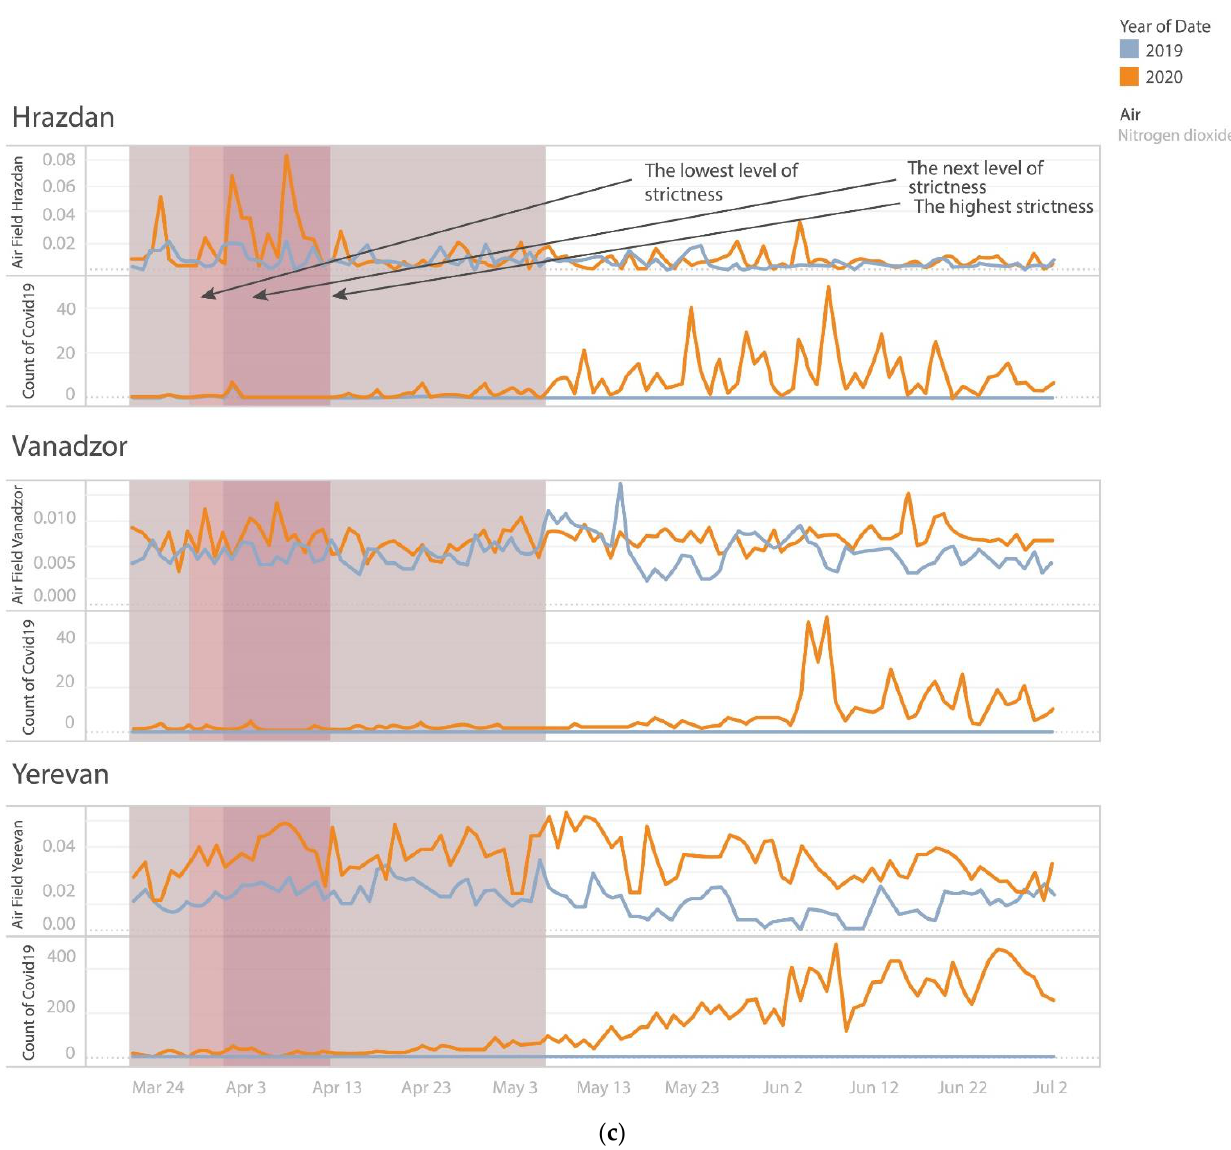
Figure 3. Concentrations of dust ( a ), sulfur dioxide ( b ) and nitrogen dioxide ( c ) and new cases of COVID-19 in Yerevan, Vanadzor and Hrazdan during March – June in 2019 and 2020 during the periods of different levels of stringency in terms of lockdown restrictions.